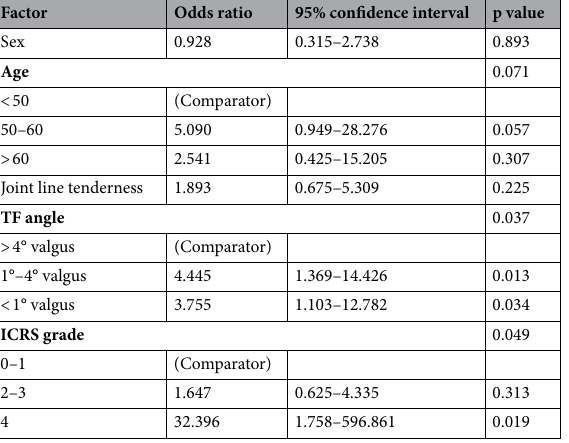
Table 2. Multiple logistic regression analysis results of factors to the failure of non-surgical treatment. TF angle tibiofemoral angle (joint alignment on the simple posteroanterior radiograph), ICRS International Cartilage Repair Society.